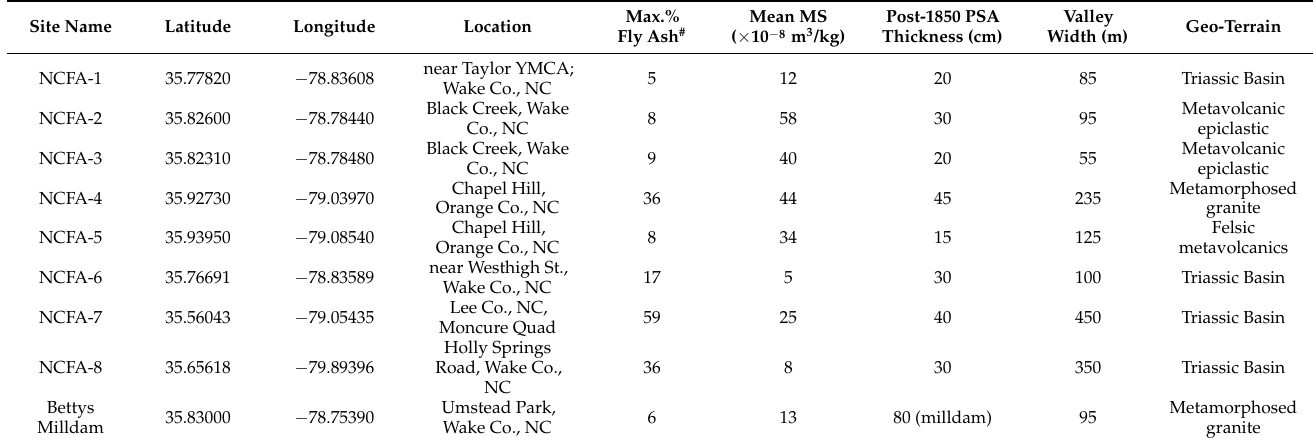
Table 1. NC Fly Ash Site